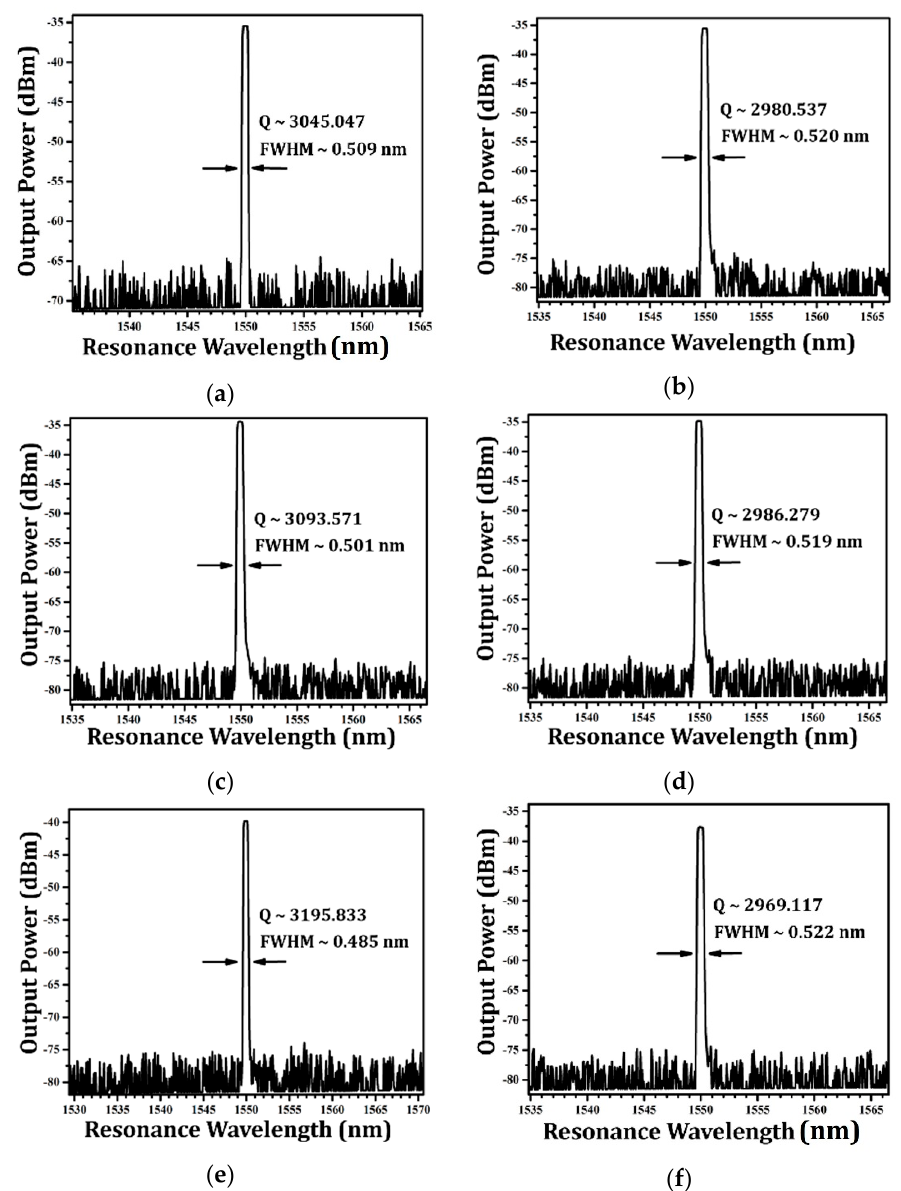
Figure 8. The measurement results at the through-port of the MRR device from ( a ) sample 1, ( b ) sample 2, ( c ) sample 3, ( d ) sample 4, ( e ) sample 5, and ( f ) sample 6. The values of quality factor, Q, and FWHM for each resonance peak are also shown.